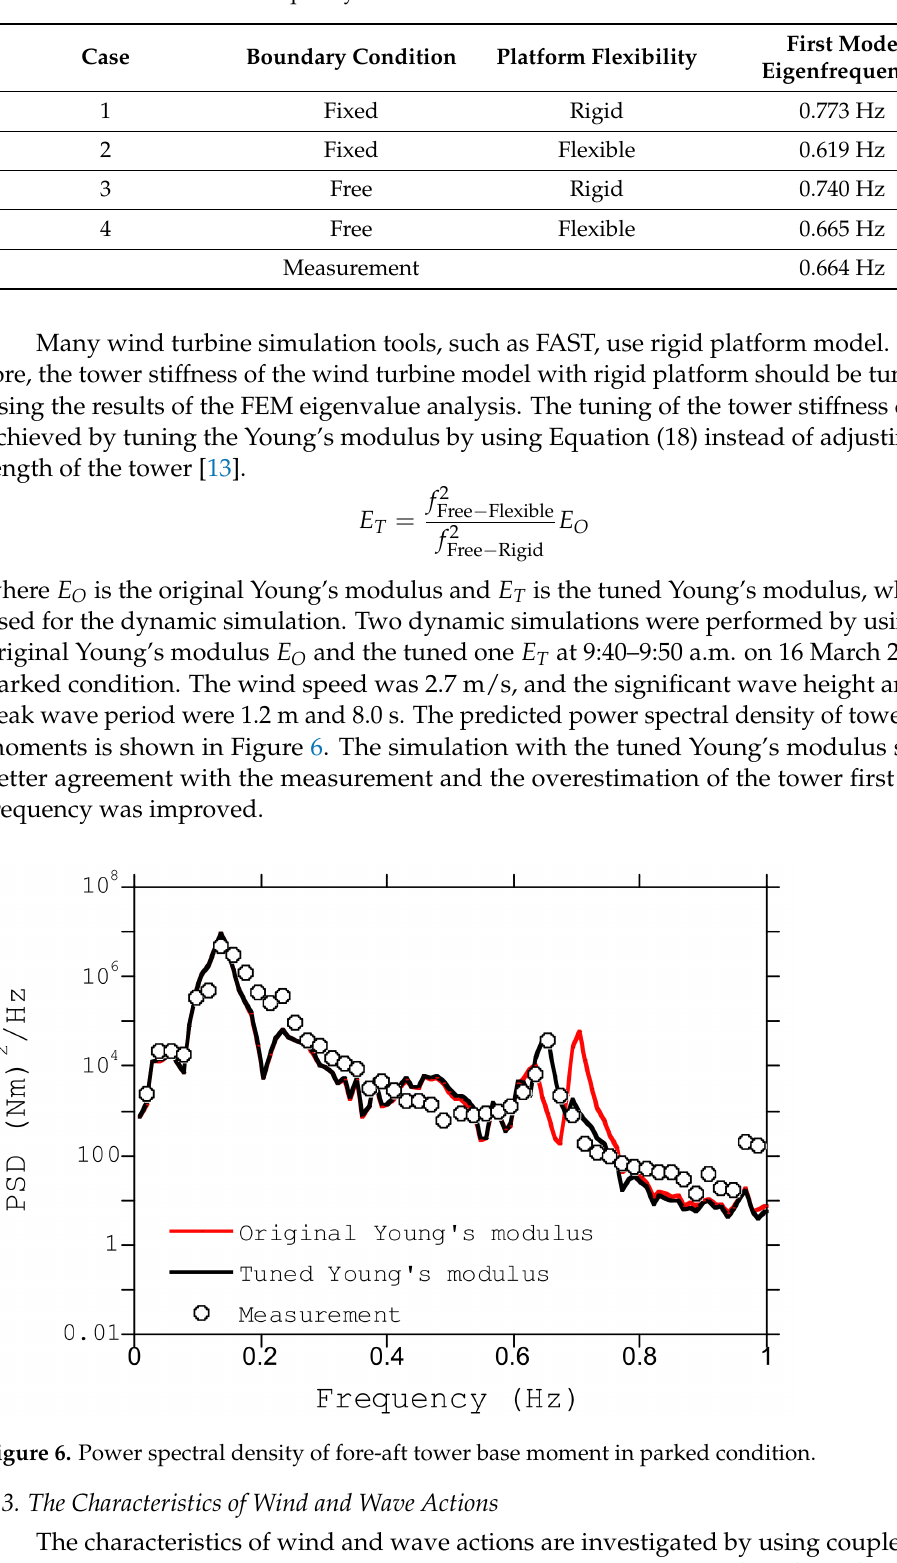
Table 5. First mode natural frequency.